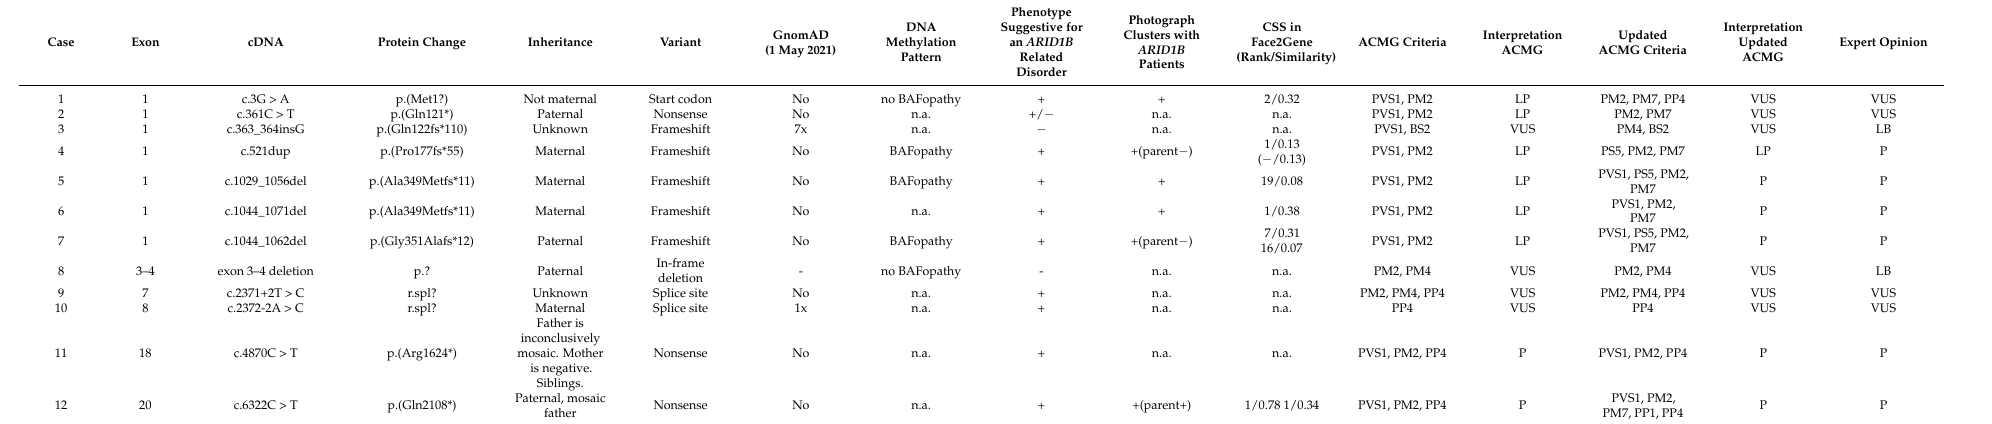
Table 1. An overview of the included patients’ variants in ARID1B and a summary of the variant and phenotype assessments. (Transcript